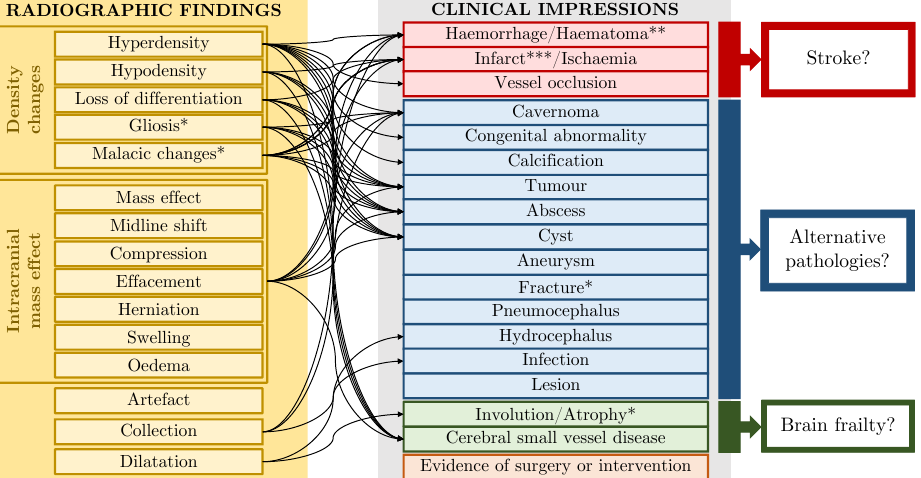
Figure 3. Label schema: 13 radiographic findings, 16 clinical impressions and 4 crossover labels which are indicated with a single asterisk. Finding → impression links are shown schematically. * These labels fit both the finding and impression categories. ** Haematoma can indicate other pathology e.g., trauma. *** Where labels refer to chronic (rather than acute) phenomena, they indicate brain frailty